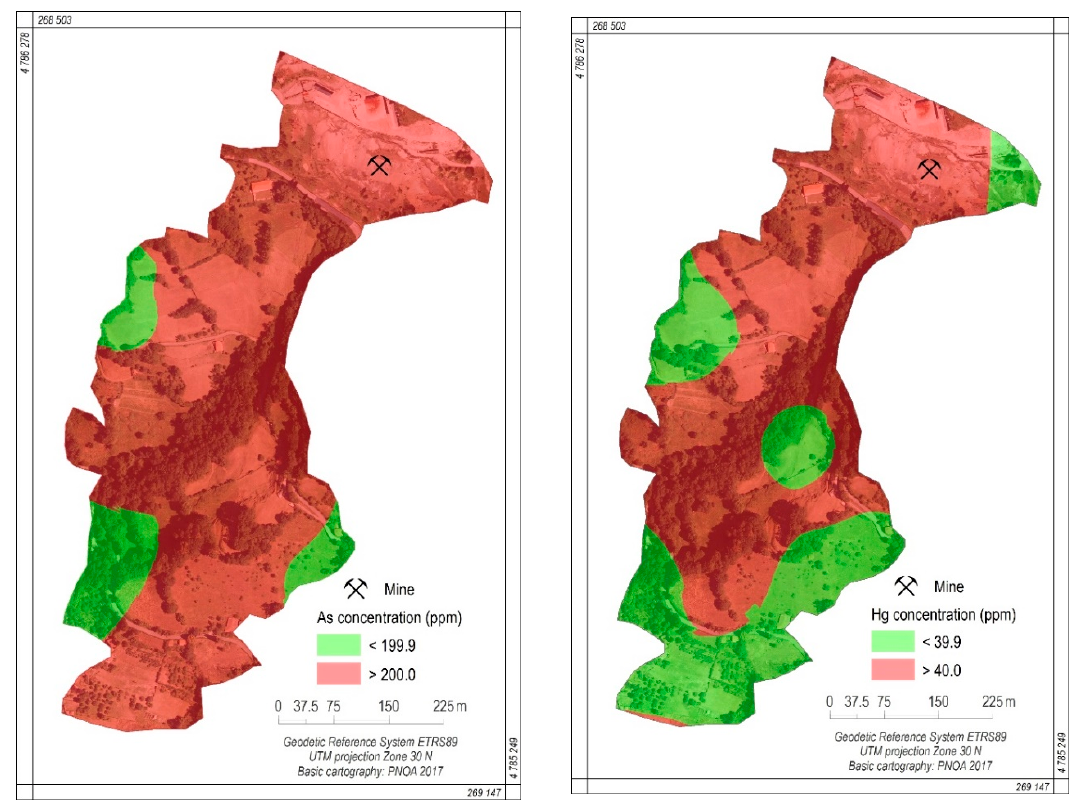
Figure 7. In red, areas that lend themselves to study by means of multispectral remote sensing techniques with a high degree of reliability. Left: As; right: Hg.